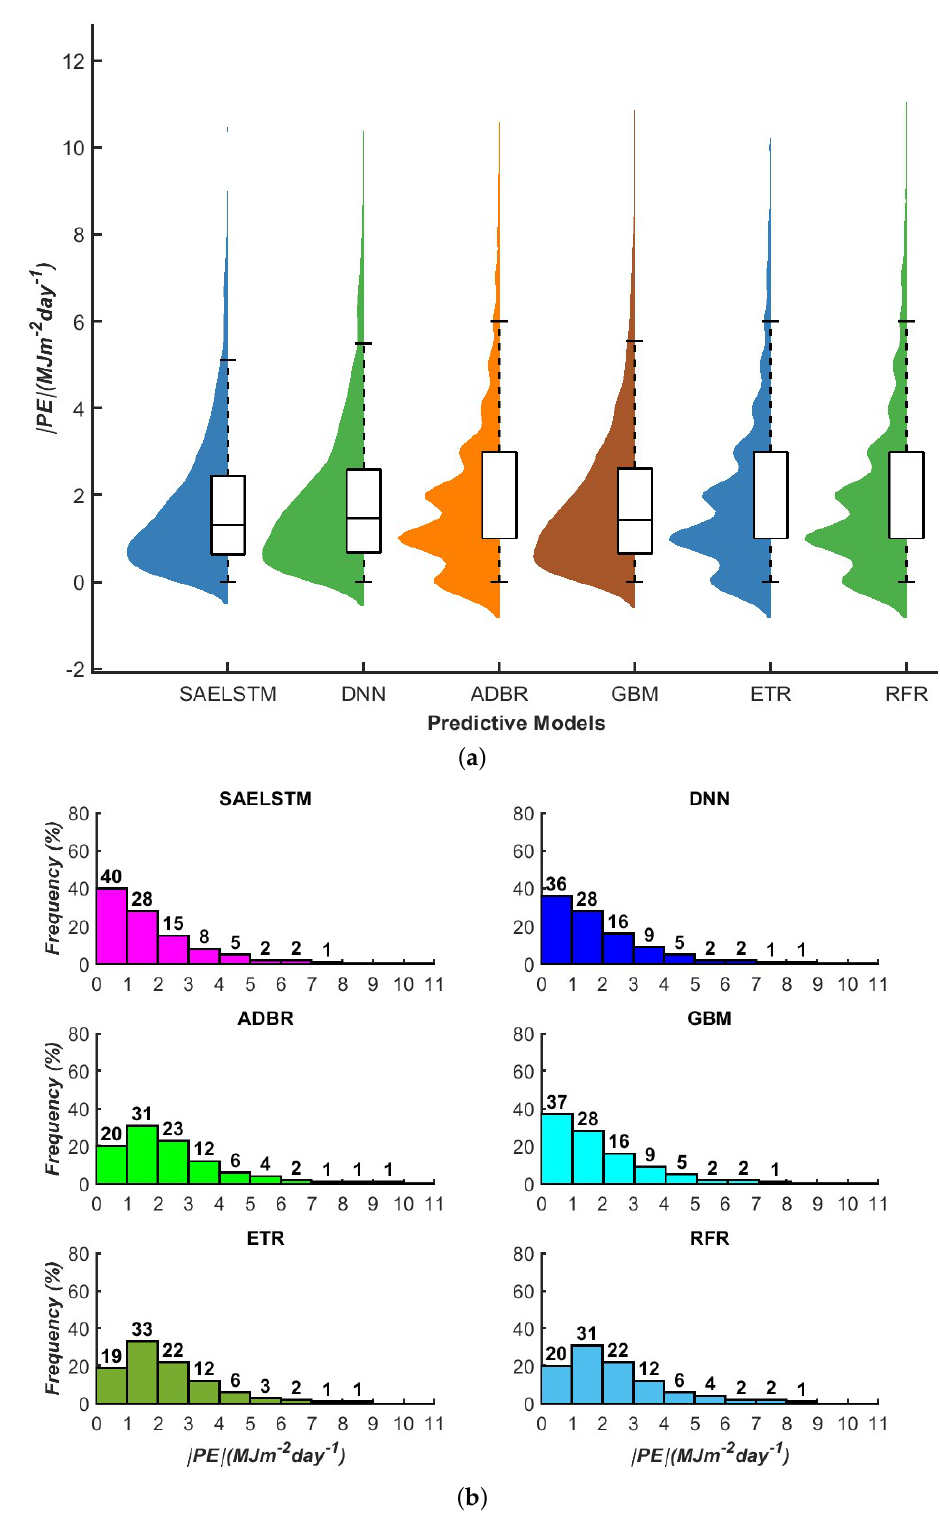
Figure 9. ( a ) Violin plots of prediction error (PE) generated in the testing phase for daily GSR prediction. ( b ) The cumulative frequency of daily forecast error ( ± 1.0 MJm − 2 day − 1 ) for all tested sites. (For model names, see Tables 3 and A1 in Appendix